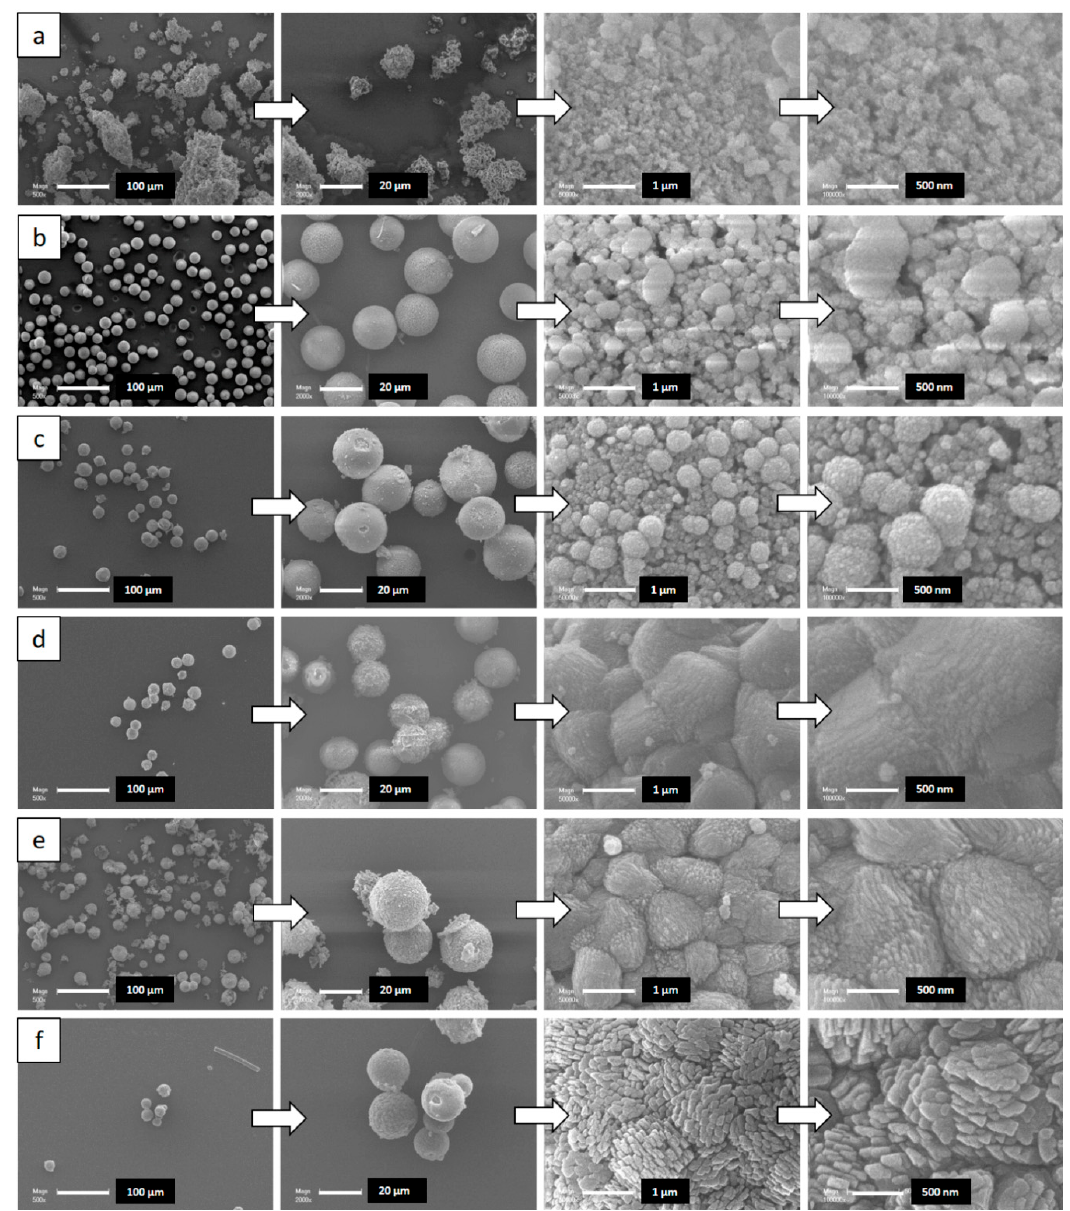
Figure 2. SEM images of all samples ( a ) 4-S ( b ) 4-NS ( c ) 5-NS ( d ) 7-NS ( e ) 14-NS ( f ) 21-NS obtained after the pseudomorphic transformation of the amorphous silica beads.